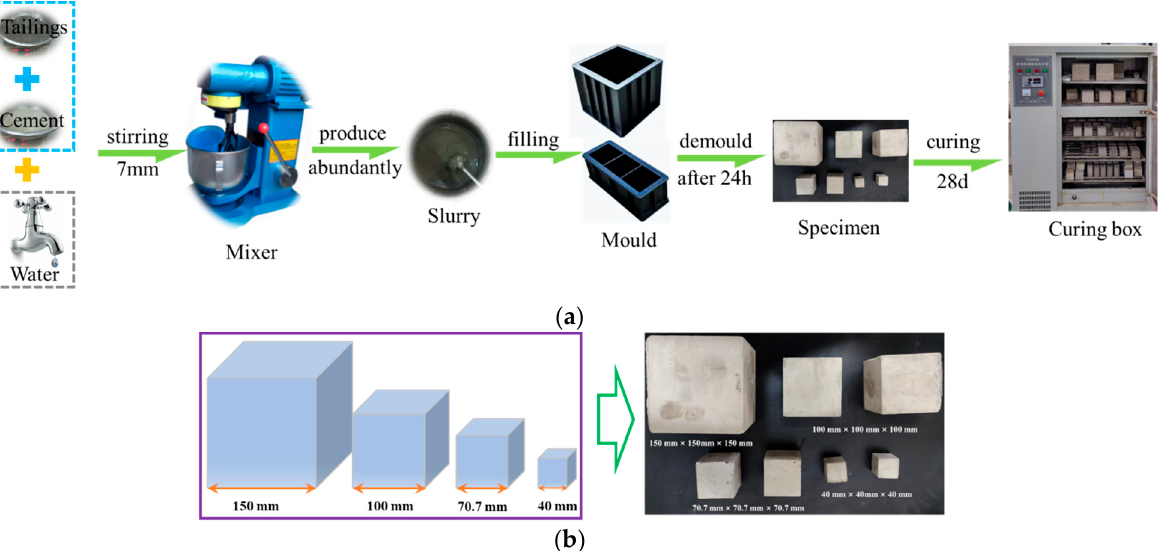
Figure 2. Backfill specimens; ( a ) specimen production process, ( b ) schematic diagram and partial specimens.